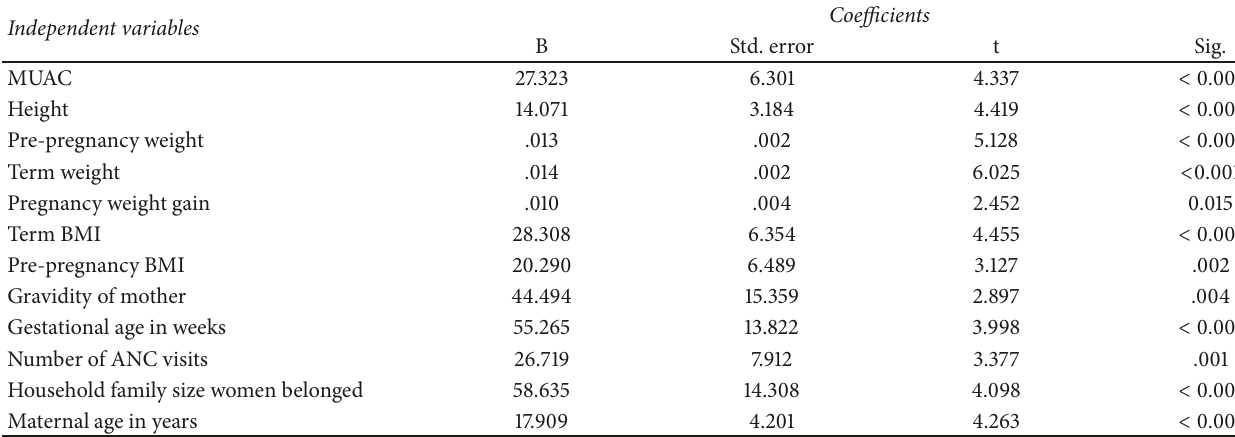
Table 2: Bivariate linear regression analysis between maternal age, anthropometry, family size, number of ANC, gravidity, gestational age, and income with birth weight.